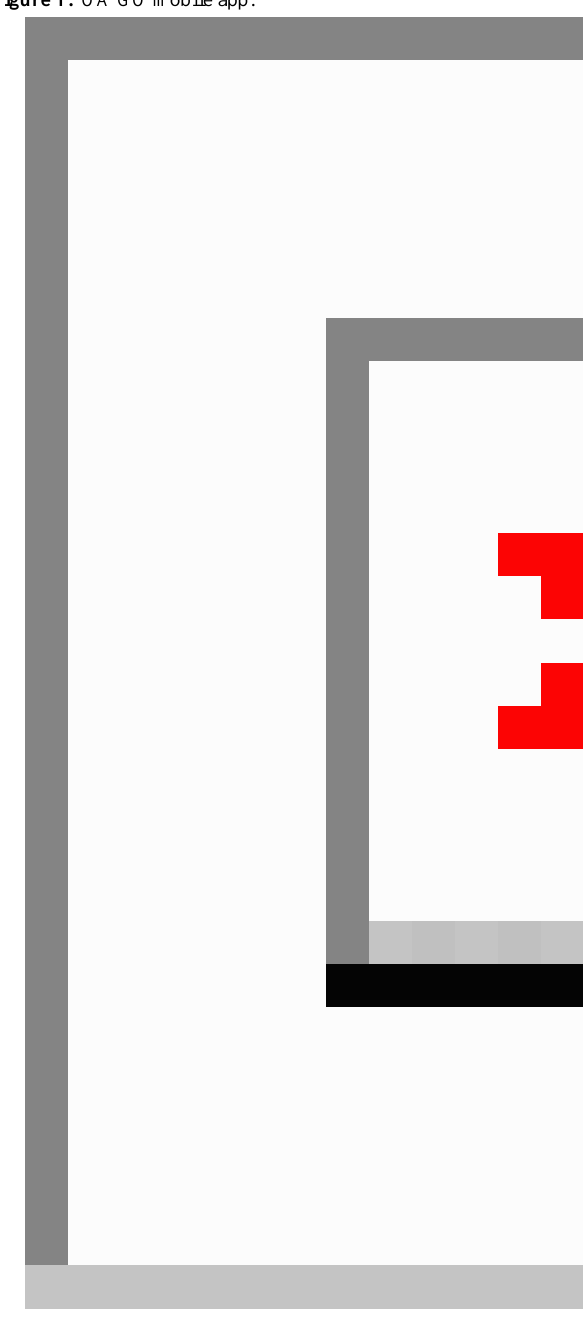
Figure 1. OA GO mobile